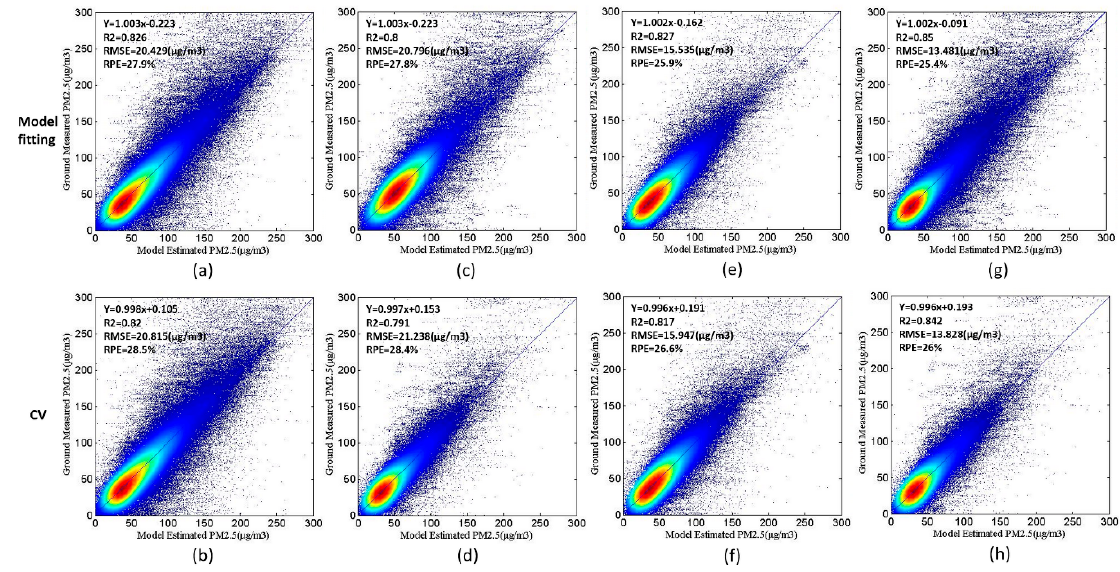
Figure 4. The accuracy evaluation of predicted PM 2.5 in group (i) from the first-stage GAM model. (a) and (b): 2013; (c) and (d): 2014; (e) and (f): 2015; (g) and (h): 2016. The red lines are regression lines.